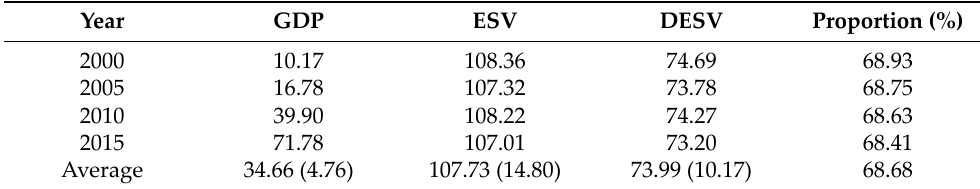
Table 5. Response rate of three types of ESVs to unit demand.